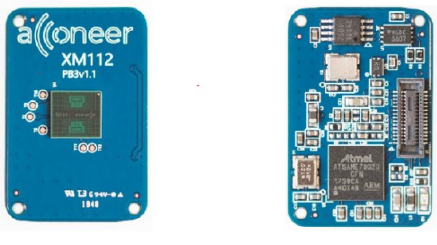
Fig. 1. XM112 PCR sensor